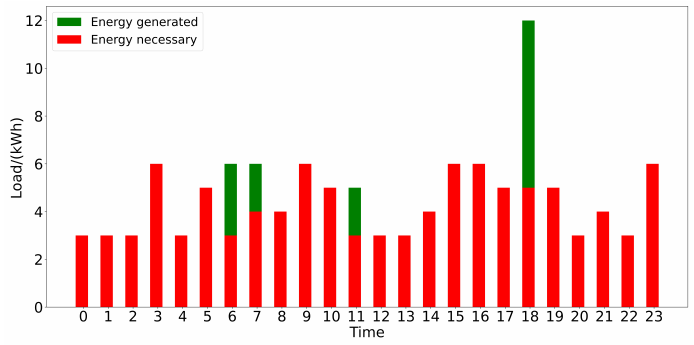
Figure 4. Necessary load and energy generation of “User 1”.